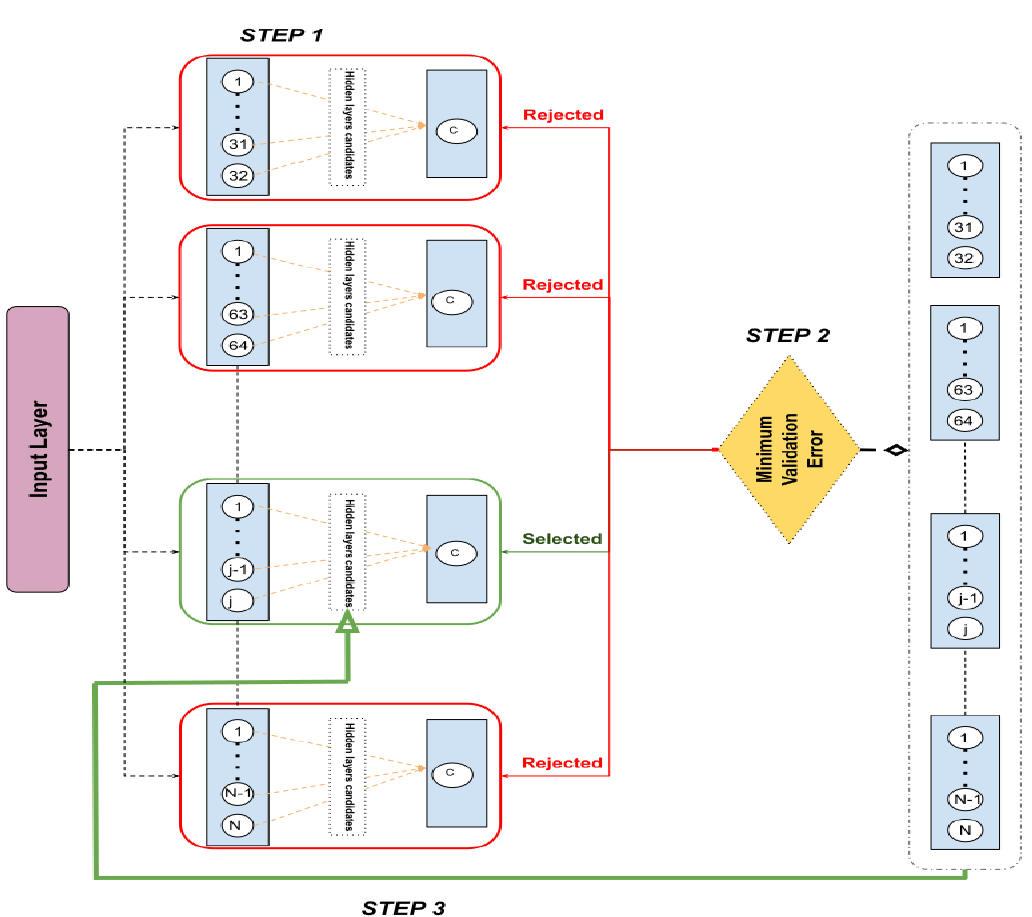
Figure 2. Binary multi-layer perceptrons components overview.